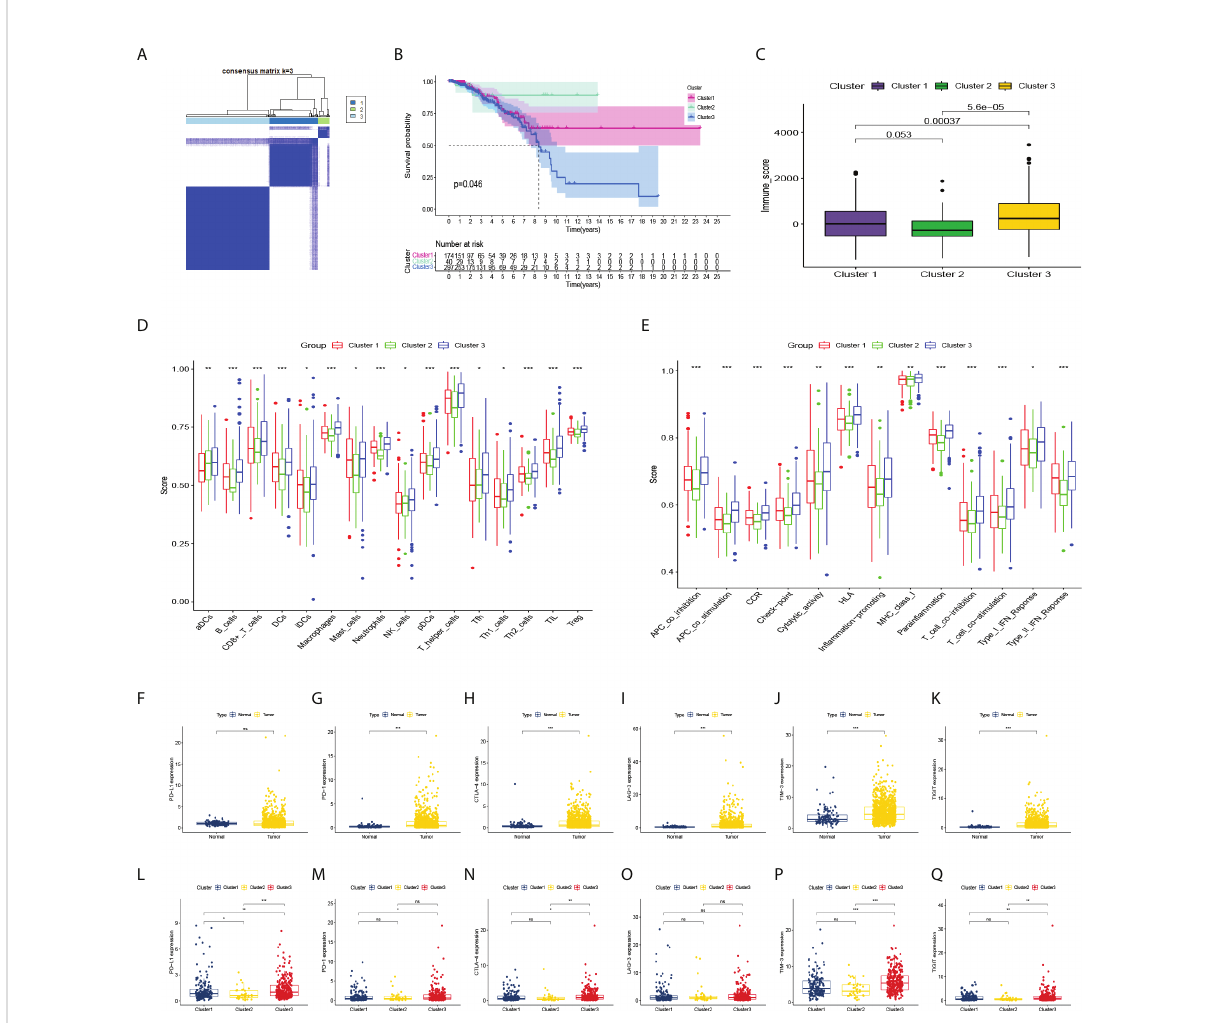
FIGURE 3 Consensus clustering and correlation of immunity. (A) Consensus clustering matrix for k = 3. (B – E) Kaplan-Meier curves, immune score, and the in fi ltrating levels of immune cell and immune function types of 3 clusters. (F – K) The expression levels of PD-L1, PD-1, CTLA-4, LAG-3, TIM-3, TIGIT in BC patients and normal people, and (L – Q) in 3 clusters. ns, not signi fi cant. *p < 0.05, **p < 0.01, ***p <